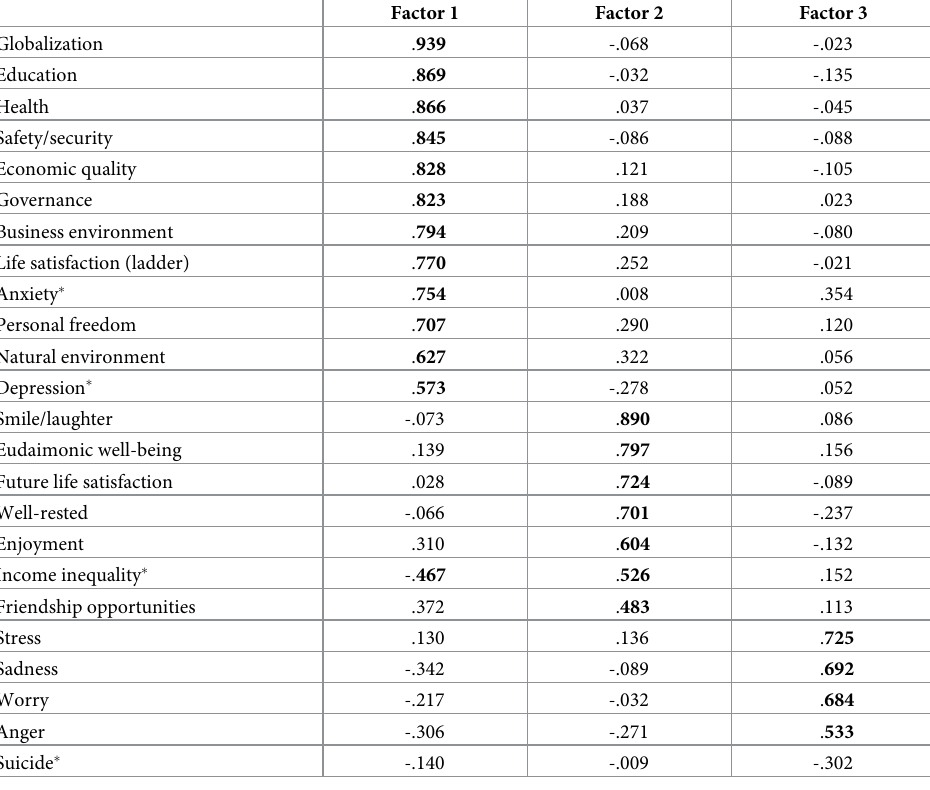
Note . Factor loadings > .4 are shown in boldface. � Variables with unexpected